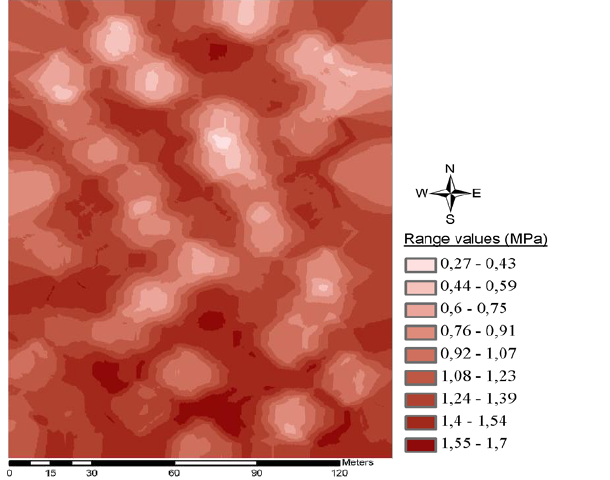
Figure 7. Soil Resistance map for 40 cm depth in